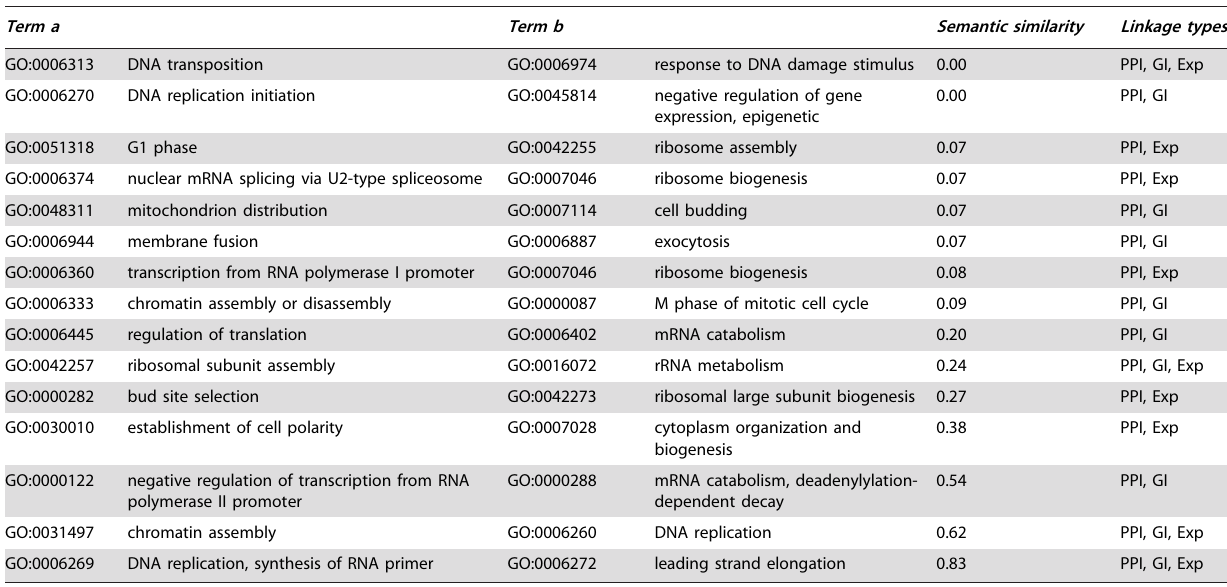
Table 1. Fifteen examples of PPI-linked processes.